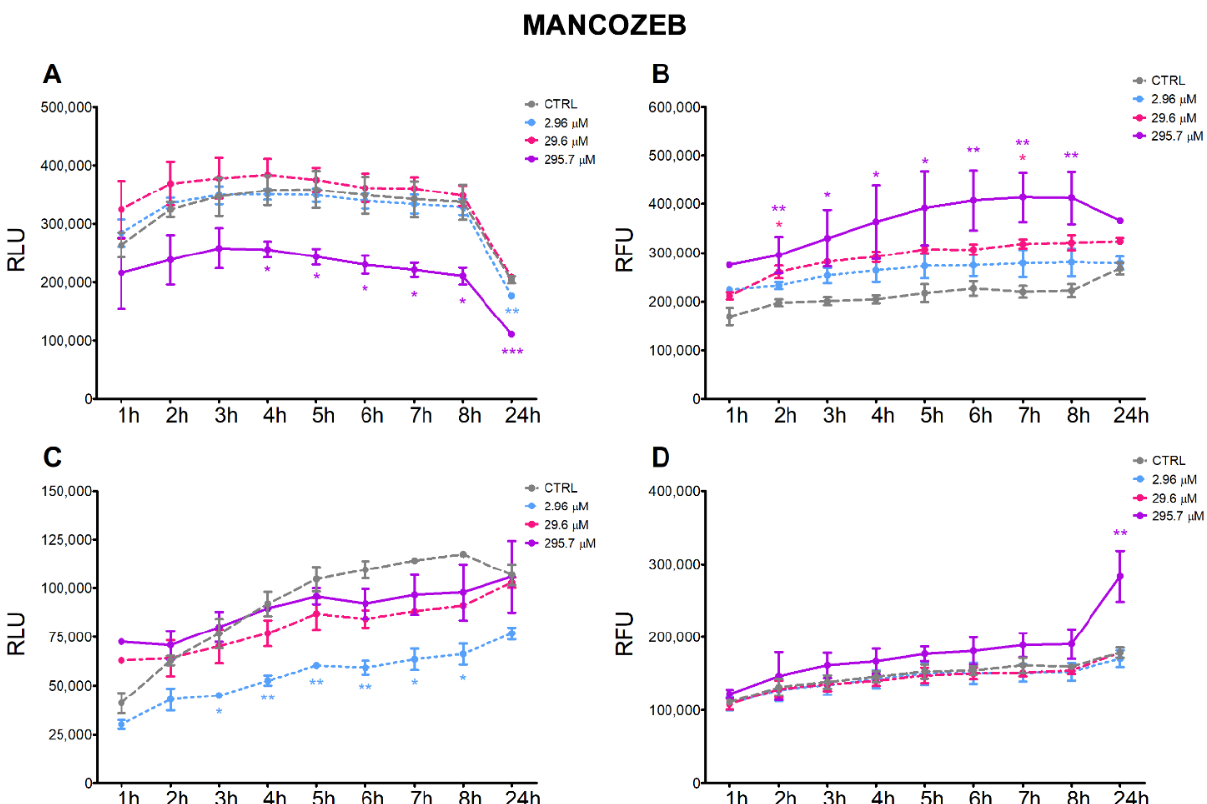
Figure 2. Apoptotic (RLU) and necrotic (RFU) signals evaluated by Annexin V assay in HepG2 ( A , B ) and A549 ( C , D ) cells treated with MZ or solvent control (0.8% DMSO) for 24 h. Values are mean fold-change ± SEM of three independent experiments. Statistical significance is indicated by asterisks: * p < 0.05; ** p < 0.01; *** p < 0.001.